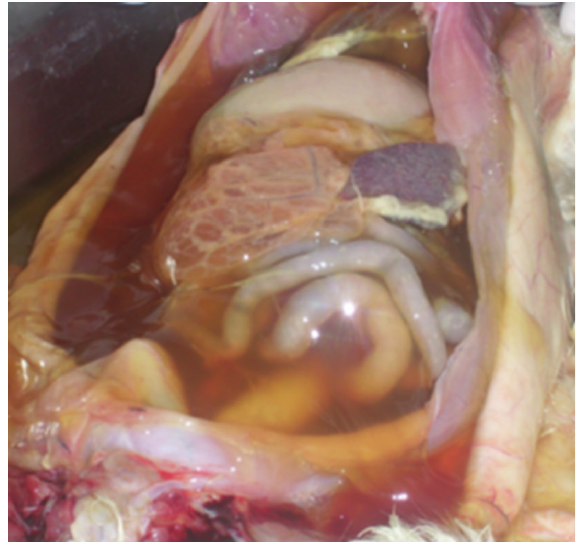
Figure 1: Peritoneal cavity of a cat with e ff usive FIP. A considerable amount of ascitic fluid can be seen in the abdominal cavity.